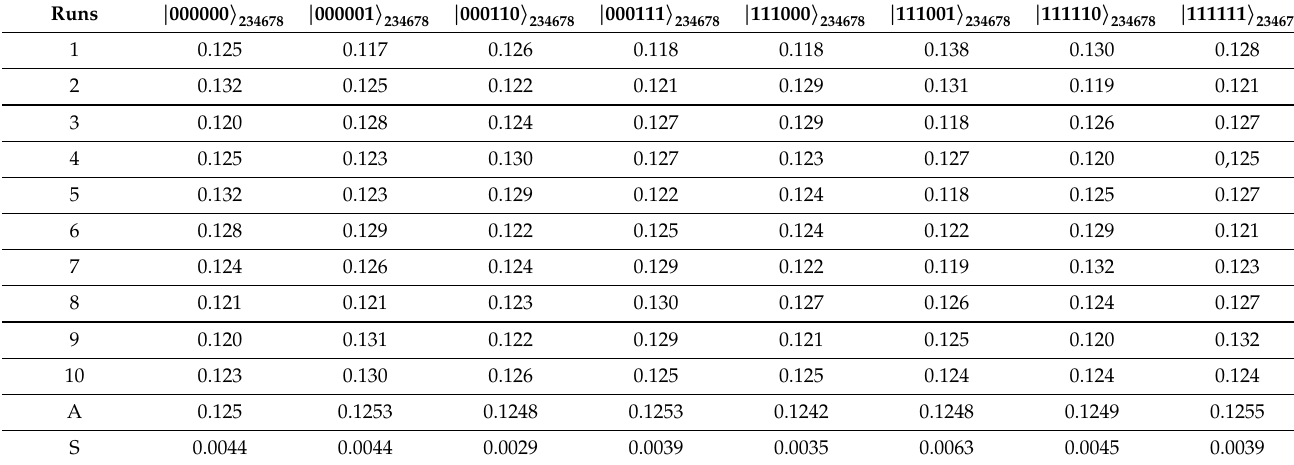
Table 2. Data analysis of the output state, where A is short for the average value, S is for standard deviation.